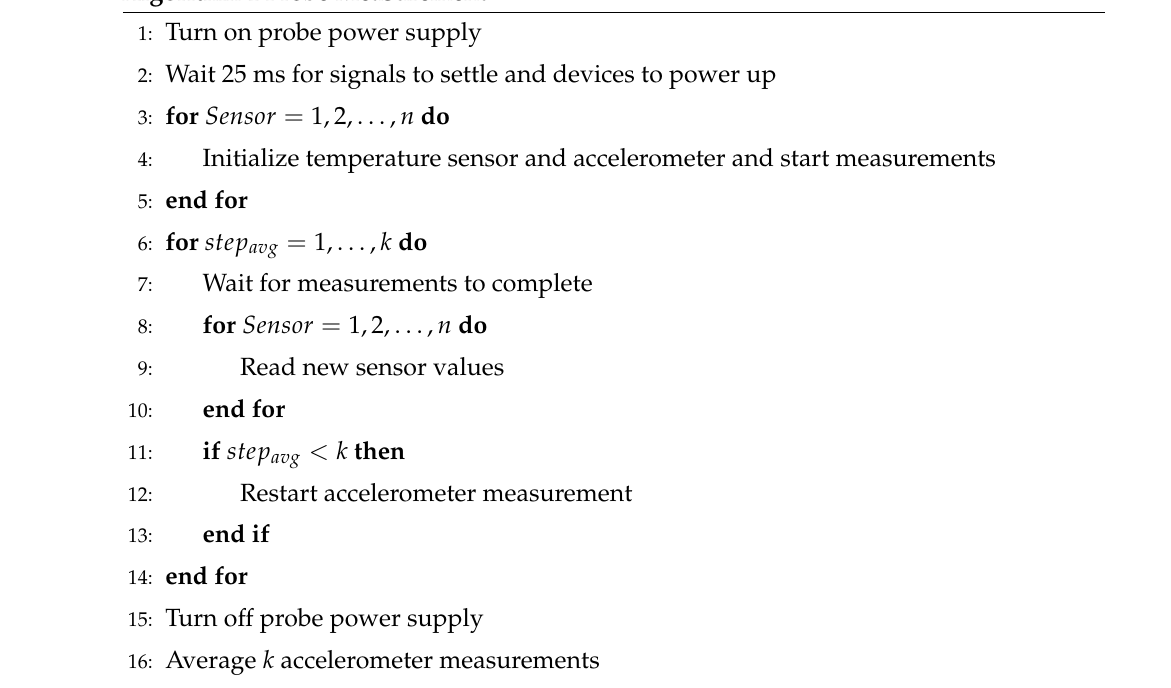
Algorithm 1 Probe